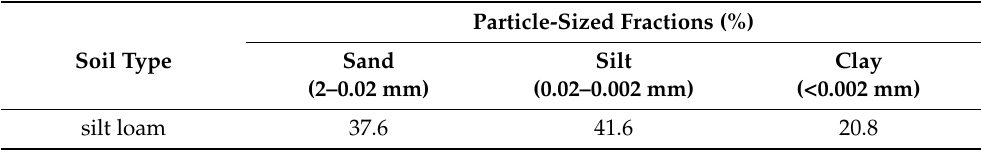
Figure 3. The soil test platform: ( a ) outside the platform, ( b ) inside the platform, ( c ) sieve soil, ( d ) inside the platform after waterproof treatment, and ( e ) buried location of WUSN nodes. Table 1. Basic physical properties of the soil for test.